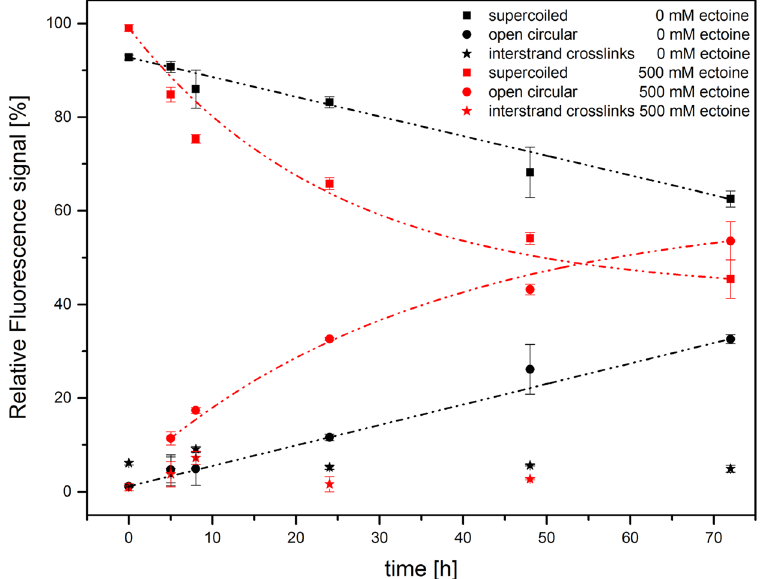
Figure 2. Plasmid pUC19 incubated for 0 h to 72 h with and without ectoine. Quantification of plasmid isoforms per sample (n = 3) via relative fluorescence signals from gel data. Incubation data without ectoine and in 500 mM ectoine solution show a decrease of the supercoiled form depending on the time and an increase of the open circular form. Amounts of interstrand crosslinks of plasmids are not changed. Lines are guides to the eye.